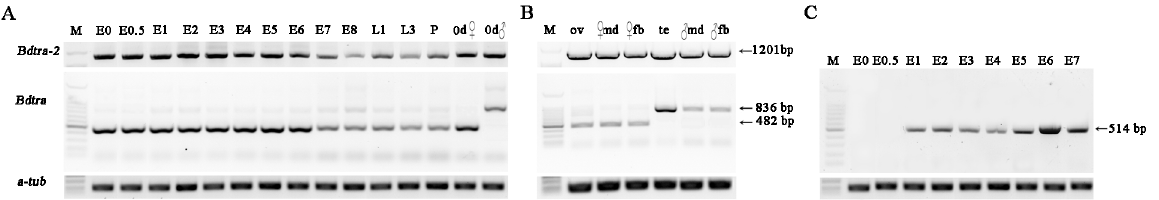
Fig 2. Expression patterns of Bdtra and Bdtra-2 . (A, B) RT-PCR with Bdtra primers 225+/706- yielded male and female products with different sizes as indicated. RT-PCR with Bdtra-2 primers 9+/1185- yielded male and female products of the same size. (C) RT-PCR with male-specific primer ms43+ and non- sex specific primer 706- to amplify the male-specific product. M, 100 bp DNA ladder (Takara); E0 – E8, mixed sex embryos collected 0 – 0.5 h, 0.5 – 1 h, 1 – 2 h, 2 – 4 h, 4 – 6 h, 6 – 8 h, 8 – 10 h, 10 – 14 h, 14 – 21h and 24 – 48 h after egg laying, respectively; L1, first instar larvae of mixed sex; L3, third instar larvae of mixed sex; P, newly pupated pupae of mixed sex; 0d ♀ ,newly emerged female adult; 0d ♂ , new emerged male adult; ♀ md, midguts from 0d ♀ ; ♂ md, midguts from 0d ♂ ; ♀ fb, fat bodies from 0d ♀ ; ♂ fb, fat bodies from 0d ♂ ; ov, ovaries; te, testes; a-tub , reference gene a-tubulin